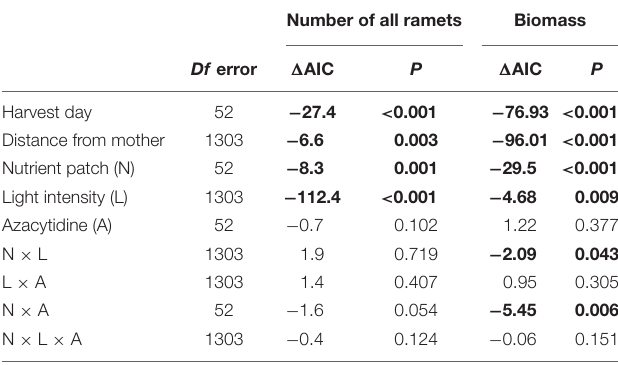
TABLE 1 | Training zone only: nutrient patches in the light or shade. Number of all